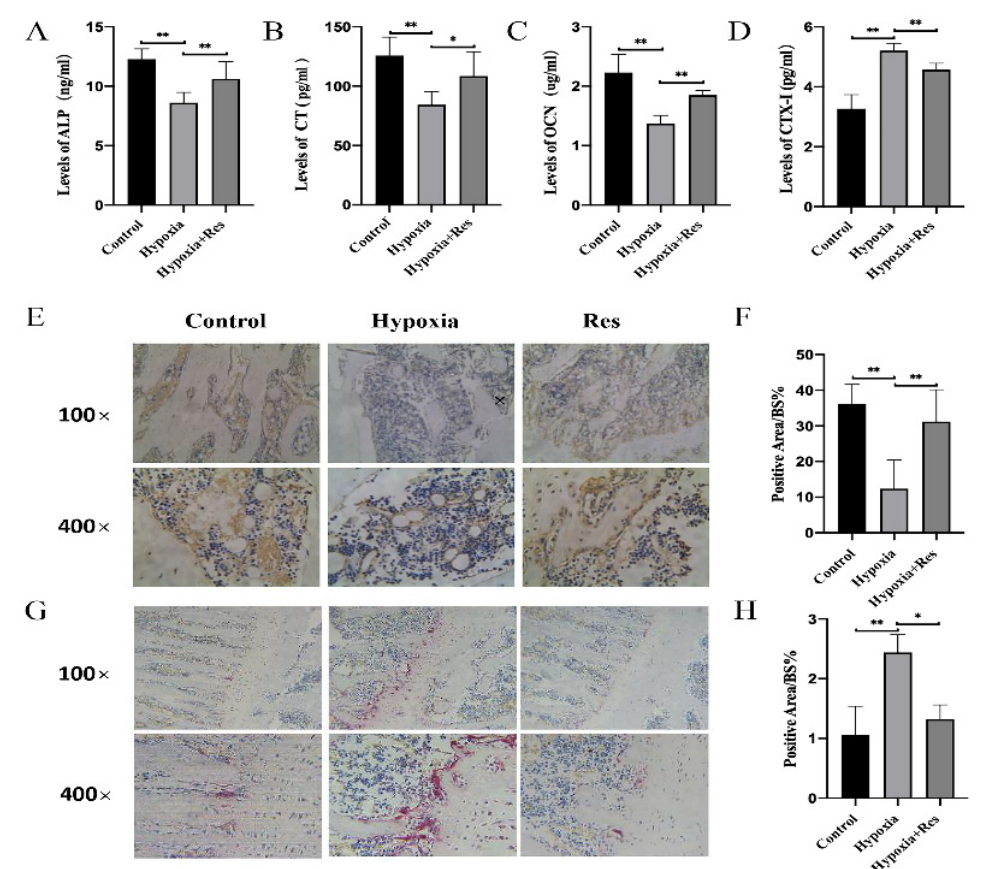
Figure 5. RES attenuated high-altitude hypoxia-induced bone remodeling dysfunction in rats. The serum level of ( A ) ALP, ( B ) CT, ( C ) OCN and ( D ) CTX-I in rats from control group, hypoxia group and RES group. ( E ) The immunochemistry results of RUNX2 staining of rats from control group, hypoxia group and RES group and ( F ) quantification. ( G ) The TRAP staining results of rats from control group, hypoxia group and RES group and ( H ) quantification. Values were expressed as mean ± SD. * p < 0.05, ** p < 0.01; all the assays were repeated more than three times.